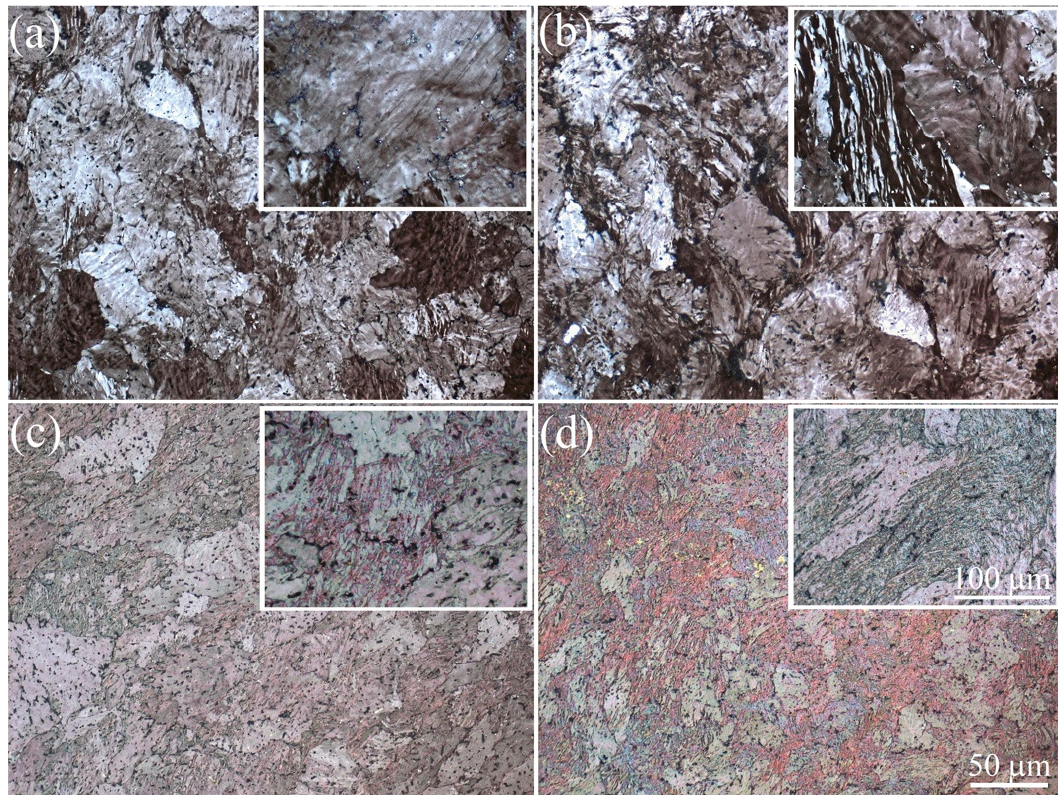
Figure 8. Structure of the median cross-section of the sample after ( a , c ) two ( ∑ e = 3) and ( b , d ) four ( ∑ e = 6) cycles at ( a , b ) 300 °C and ( b , d ) 200 °C.